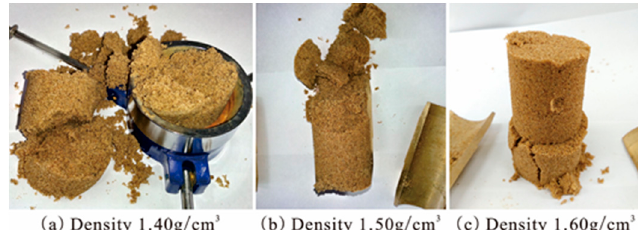
Figure 5. The shape of unreinforced specimens in unconfined compression test: ( a ) Density 1.40 g/cm 3 ; ( b ) Density 1.50 g/cm 3 ; ( c ) Density 1.60 g/cm 3 .